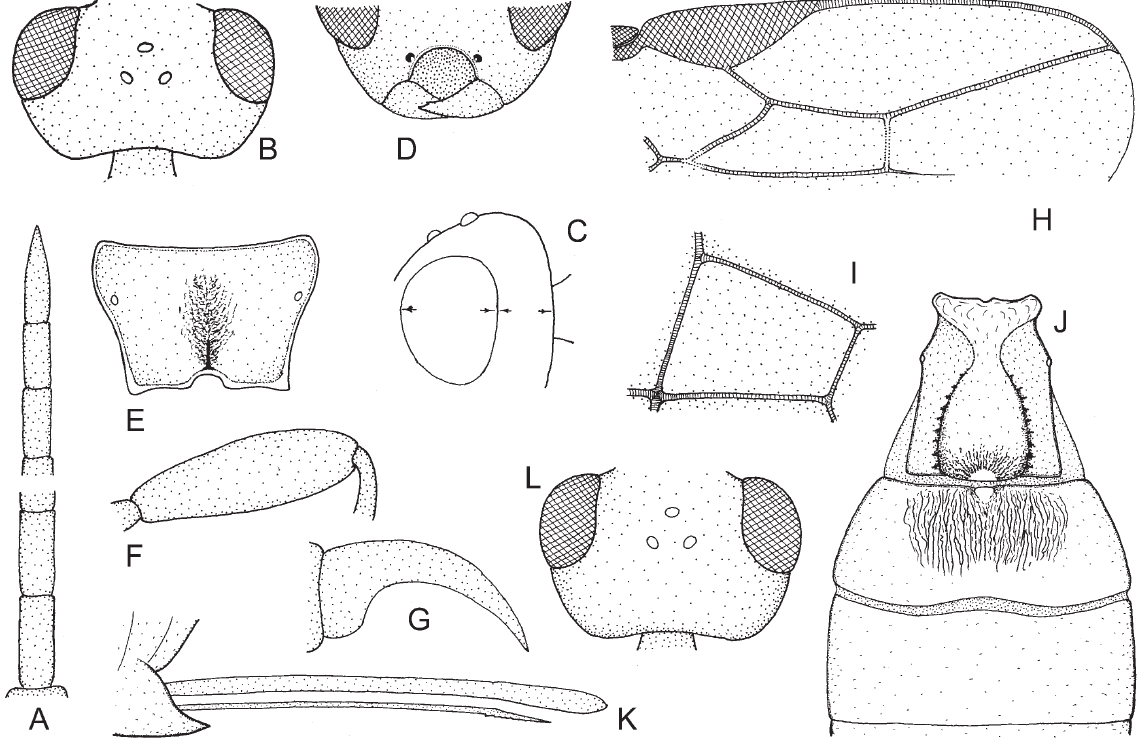
Fig. 37. Bracon ( Glabrobracon ) picticornis Wesmael, 1838 (A-K: ♀ lectotype, L: ♀ paralectotype). A . Flagellomeres 1-2 and 29-31. B . Head in dorsal view. C . Head in lateral view. D . Head in frontal view. E . Propodeum. F . Hind femur. G . Claw. H . Distal part of right forewing. I . First discal cell of right forewing. J . Tergites 1-3. K . Hypopygium and ovipositor apparatus. L . Head in dorsal